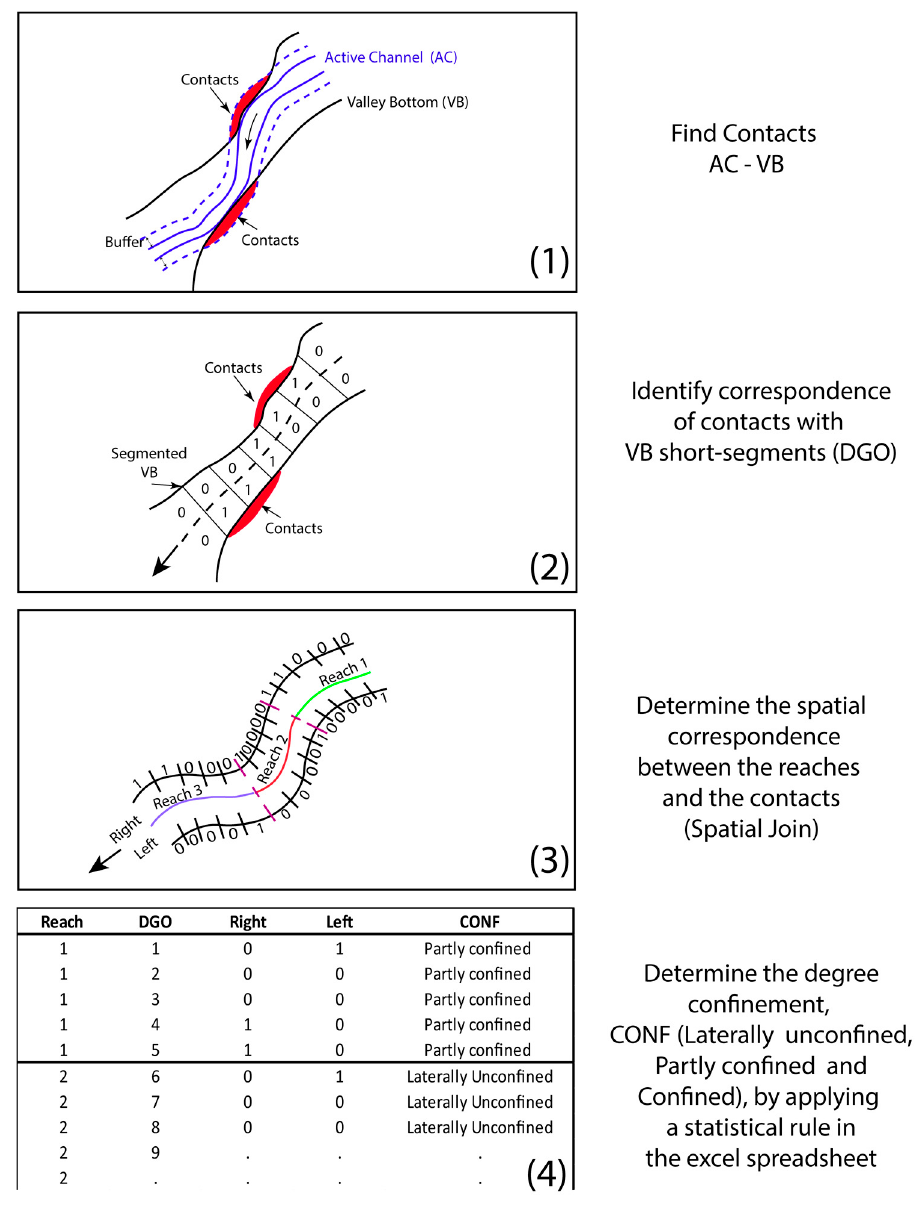
Figure 6. Steps for calculating Confinement: ( 1 ) Intersection between the valley bottom (VB) and a buffer of the Active Channel (AC) to determine contacts; ( 2 ) Determination of the correspondence between contacts and segmented VB (by applying mainly the FCT and obtaining the Discretized Geographical Objects (DGO)); ( 3 ) Determine the spatial correspondence between VB segments and contacts using the GIS tool “Spatial join”; ( 4 ) Determine the Confinement Type by applying a statistical rule using an Excel spreadsheet on the attribute table extracted from the segmented VB shapefile.